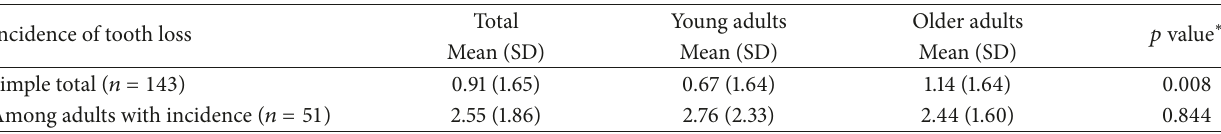
Table 2: Number of teeth lost by age group of adults for simple total and adults with incidence of tooth loss in 4 years of follow-up. Piracicaba, S˜ao Paulo, Brazil, 2011–2015.